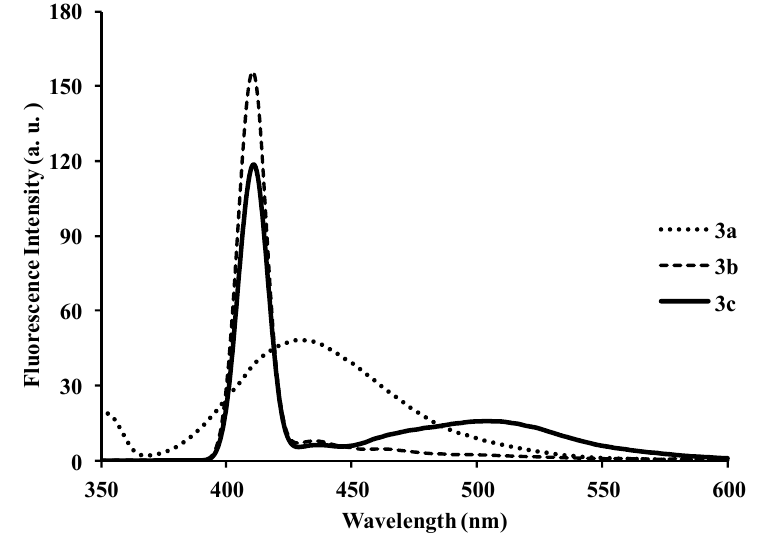
= 385 nm) in CHCl ex 3